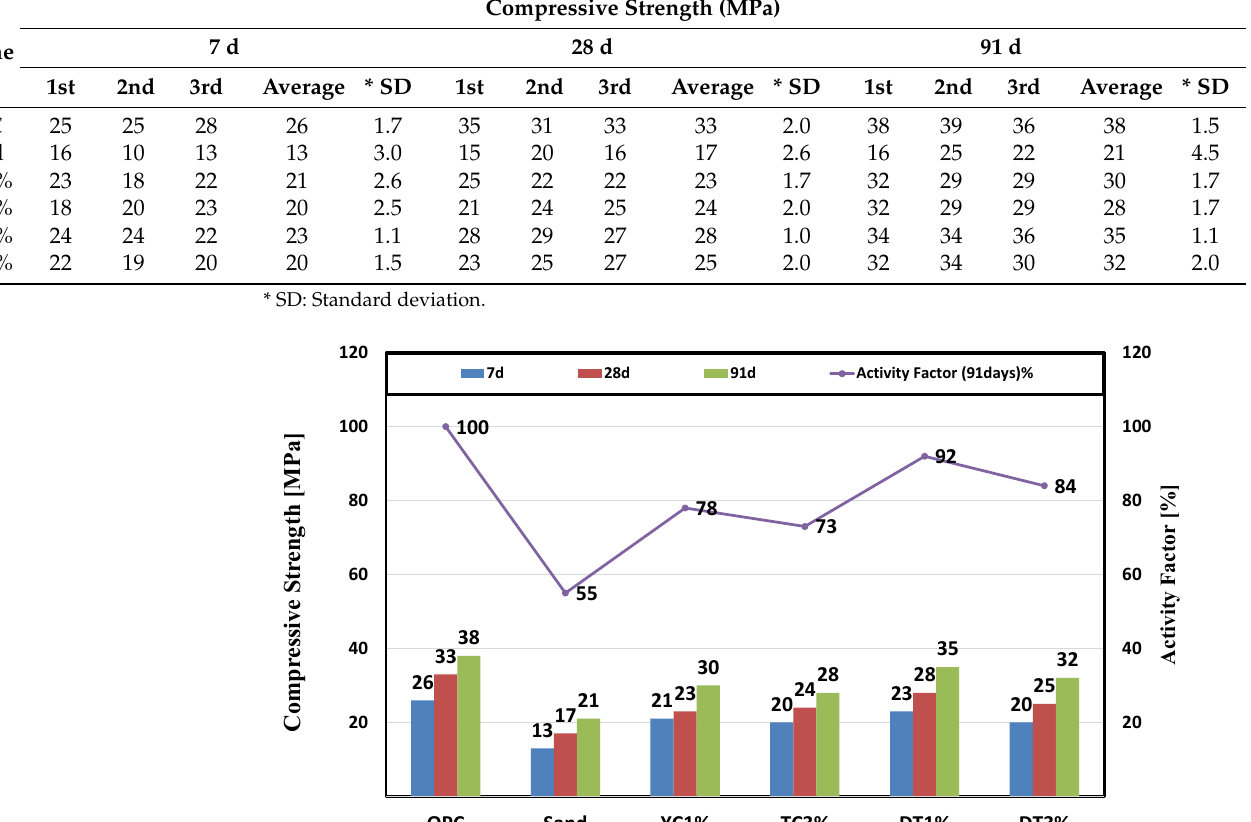
Table 6. Measurement of the physical test.